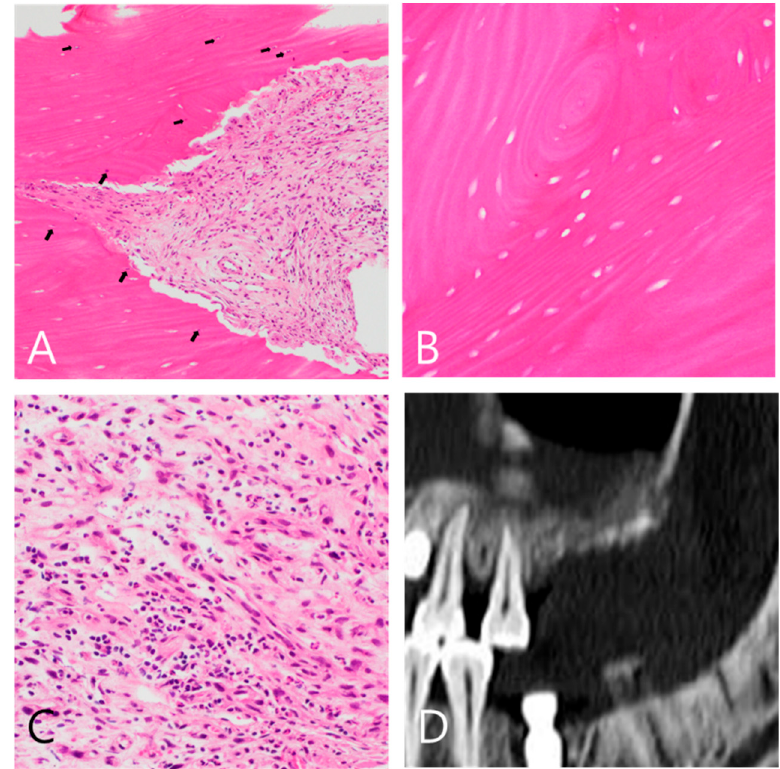
Figure 5. Histological and clinical outcomes of conservative treatment on case #2 at 10 weeks after graft surgery. ( A – C ). Histological findings of the bone fragments. ( A ) Some osteoblasts were showed inside the grafted bone matrix. (Arrow) ( B ) No evidence of bacterial invasion was showed on the grafted bone fragments with a lamella pattern and empty lacunae. ( C ) There was only chronic inflammatory cells without evidence of bacterial invasion. ( D ) At 12 months after the graft, the dehiscence area showed proper bone healing without graft failure.